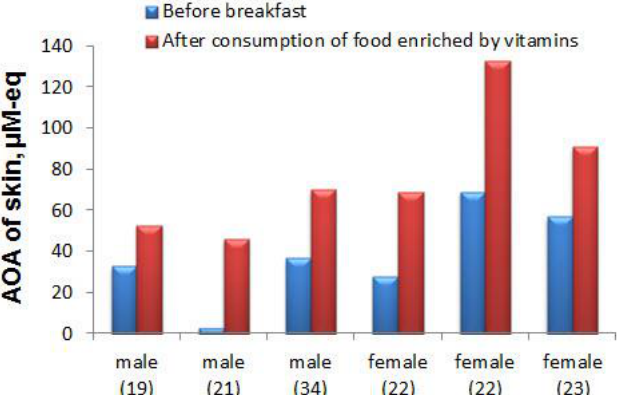
Figure 3. Influence of the use of food enriched with vitamins (100 mg ascorbic acid and 100 mg of rutoside) on the AOA of skin of the respondents. (The age of the respondents is indicated between parentheses).